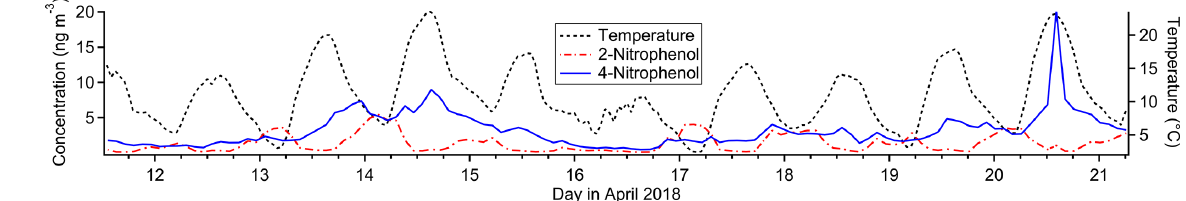
Figure 9. Timelines of nitrophenol isomers (left axis) and temperature (right axis) for the study